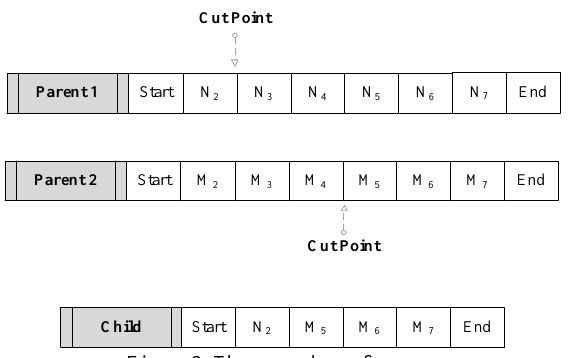
Figure 2. The procedure of crossover